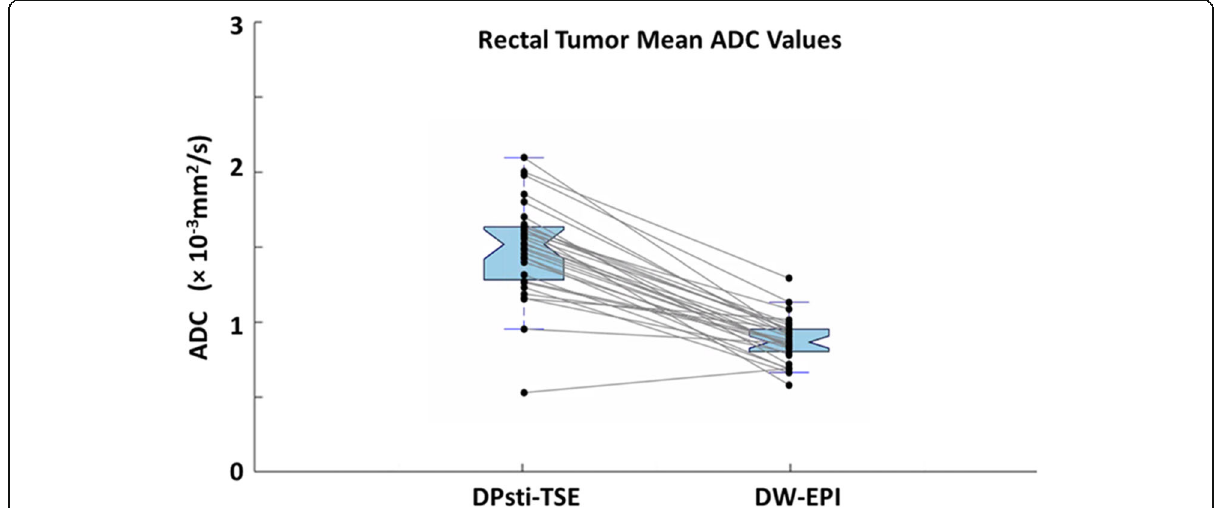
Fig. 4 Tumour ADC values for 31 patients obtained by DPsti-TSE and DW-EPI methods. The box plots show the 75th, 50th and 25th percentile of ADC values for all 29 patients. For the same patients, ADC values from DPsti-TSE and DW-EPI are connected. The DPsti-TSE method generated higher tumour ADC values than the DW-EPI method: (1.47 ± 0.32) × 10 − 3 mm 2 /s and (0.86 ± 0.15) × 10 − 3 mm 2 /s, respectively ( p < 0.001). (